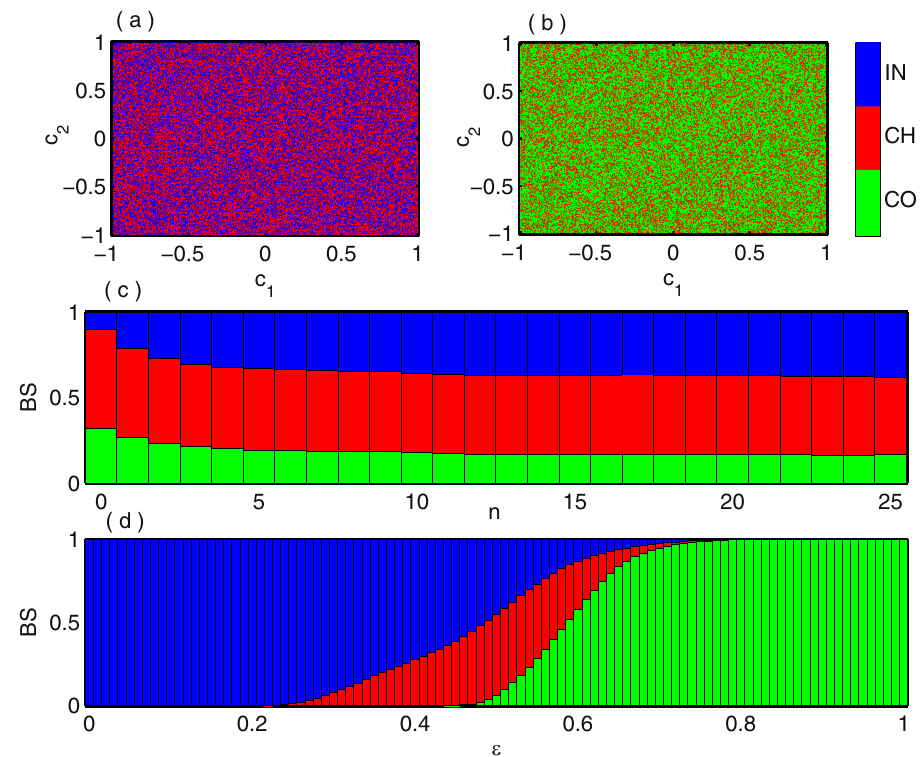
Figure 8. Globally coupled Mackey-Glass systems: Basin of attractions for the coexistence of ( a ) incoherent and chimera states at = . 0 34  , ( b ) chimera and coherent states at = . 0 56  where IN, CH and CO stands for incoherent, chimera and coherent states respectively. The basin of stability of incoherent, chimera and coherent states are plotted in ( c ) with respect to the highest degree n of the polynomial basis represented by blue, red and green colors respectively at the coupling strength = . 0 57  . ( d ) The variation of BS for incoherent, chimera and coherent states against the coupling strength 